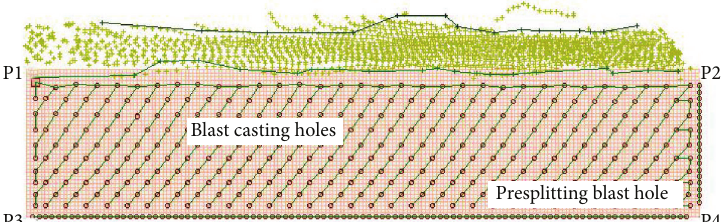
Figure 9: Design of blast casting.